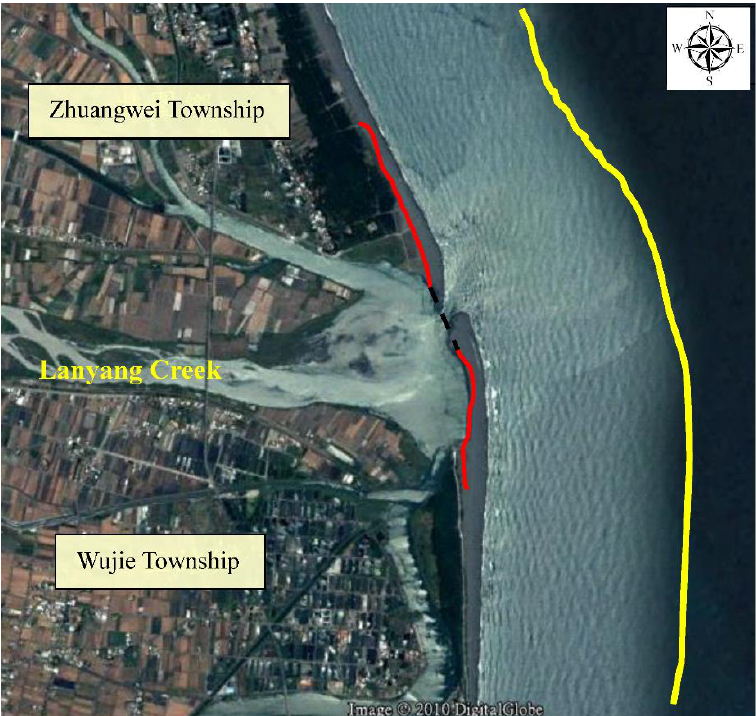
Figure 8. Preliminary planning results of coastal buffer zone using the SBEACH and wave run-up models (the estuary of Lanyang Creek, Yilan, Taiwan) [56]. (Red line: the onshore boundary of the coastal buffer zone; yellow line: the offshore boundary of the coastal buffer zone.).